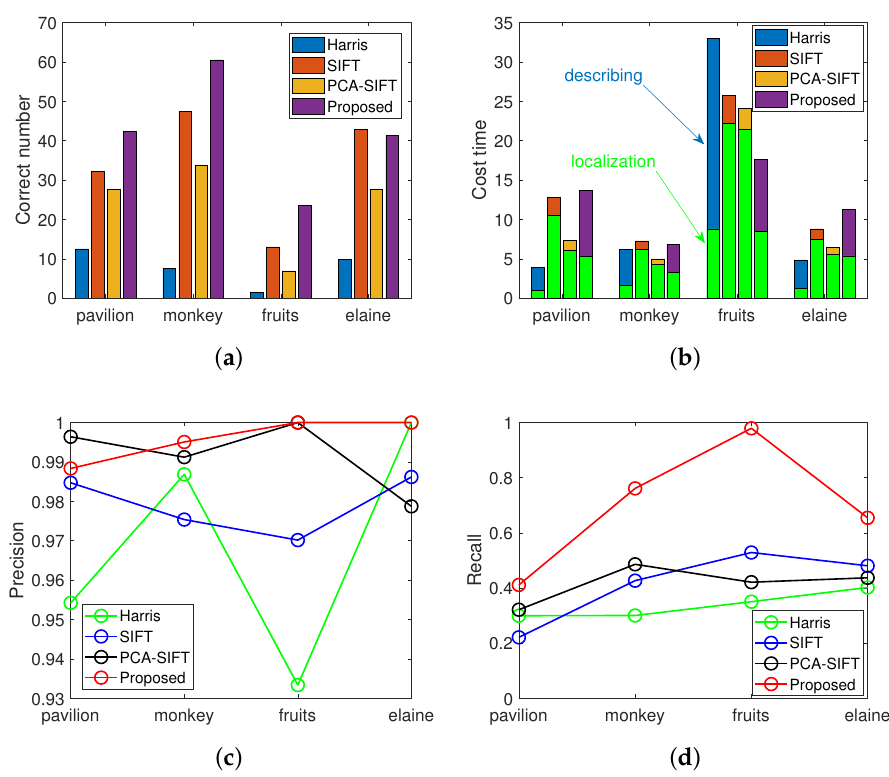
Figure 9. Results analysis of rotated and noised images matching test: ( a ) correct matching number; ( b ) cost time per match; ( c ) precision of the matches; ( d ) recall of the matches. Scaled and rotated images matching test . The four images (Pavilion, Monkey, Fruits, Elaine) are all scaled 50% after rotation by π /6. After applying the proposed method and the compared methods on each image pair, the matching results are shown in Figure 10. The proposed method finds